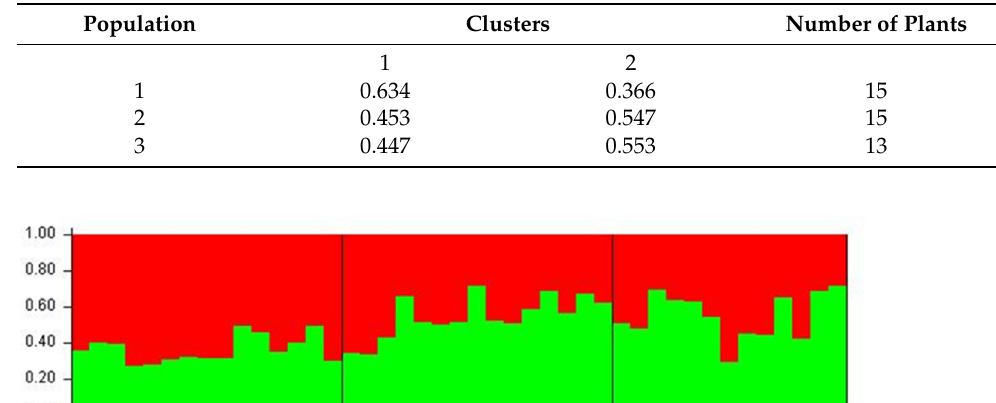
Table 8. The proportion of members of each predefined population in the two groups. Population Figure 4. Analysis of the genetic structure of three populations of Euphorbia fulgens with eight SSRs. Graph generated with the outputs of the Structure software and organized by the K value. Each color represents a cluster defined by the software for populations 1, 2, and 3.